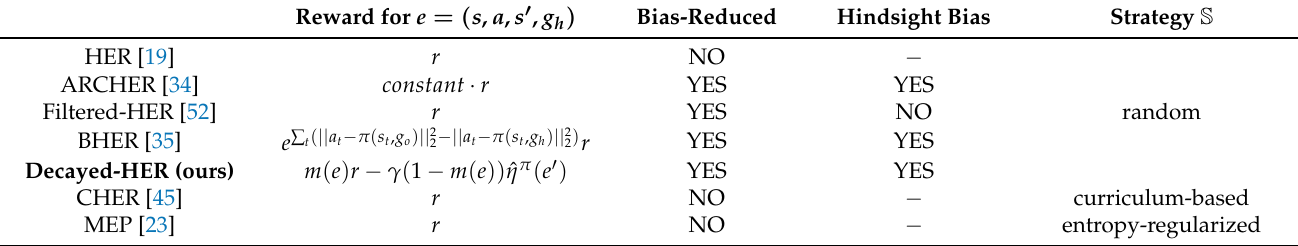
Table 1. HER variants with different hindsight rewards. The vanilla HER neglects the bias when uniformly replaying hindsight goals. ARCHER, BHER, and our Decayed-HER try to address the bias on the modified hindsights. Filtered-HER filters meaningless experiences but makes no effect on hindsight bias. CHER and MEP variants pay more attention to how to sample hindsight goals for